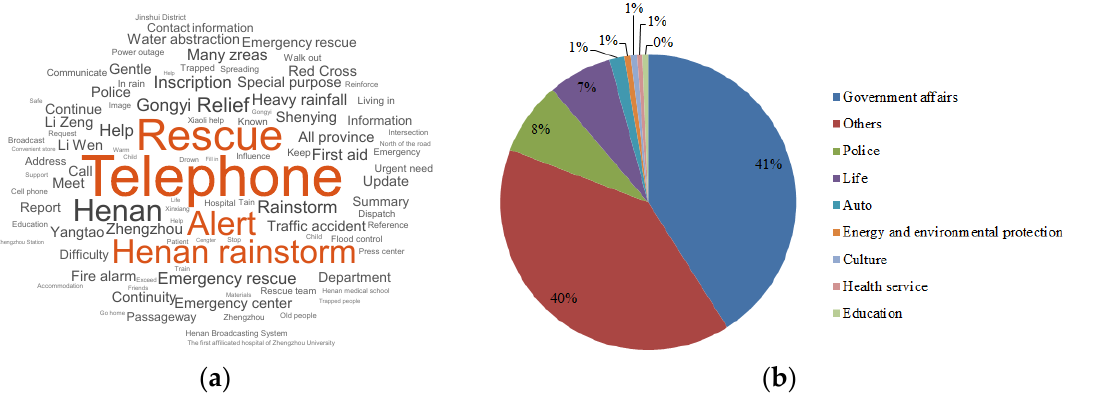
Figure 4. Hotspots regarding the Henan rainstorm from Sina Public Opinion: ( a ) keyword cloud; ( b ) proportion of information by industry.